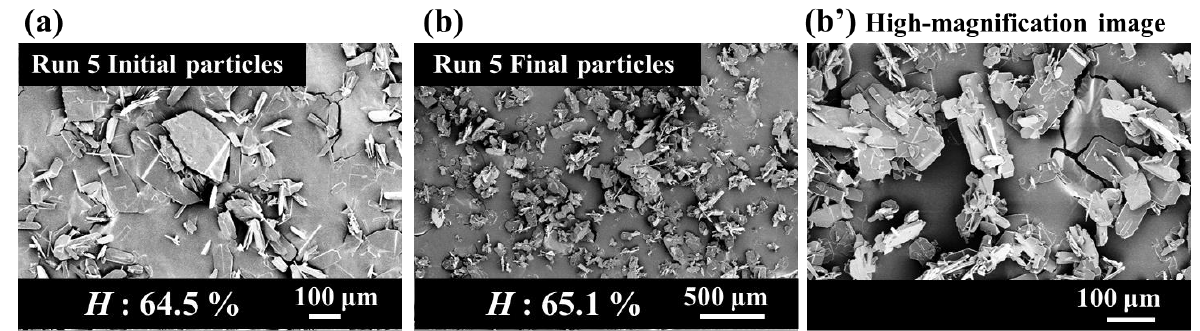
Figure 12. SEM photomicrograph of crystalline particles obtained in Run 5. ( a ) Initial particles. ( b ) Final particles. ( b’ ) High-magnification image of the final particles.